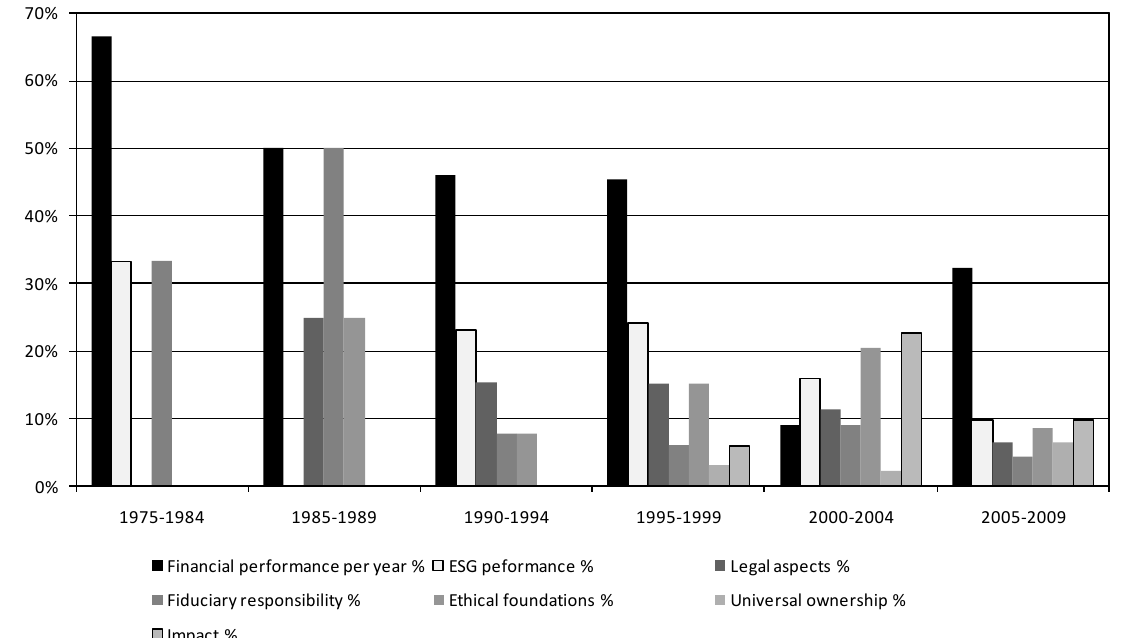
Figure 4: The appearance and frequency of themes in the sampled academic SRI literature Only a fifth of studies (20.31%) suggested that investing in a socially responsible manner represents a financial